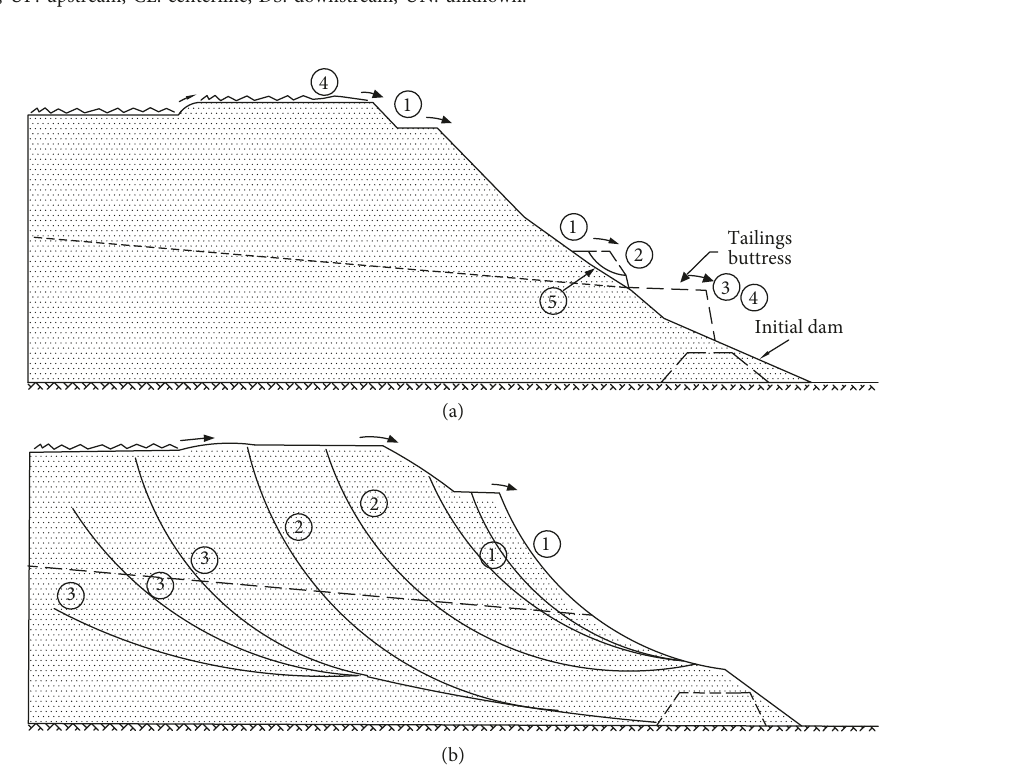
Figure 2: (a) The sequence of retrogressive failures (redrawn after Wanger et al. 1998), the early stages of flooding over the dam. (b) The sequence of retrogressive failures (redrawn after Wanger et al. 1998), the later stages of flooding over the